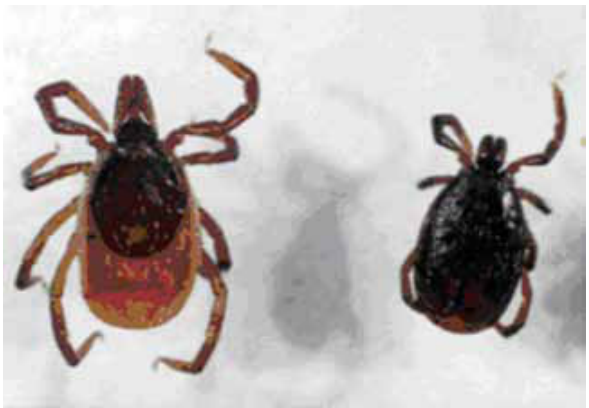
Fig. 1 – I. ricinus, adults female (left) and male (right), juriši ć